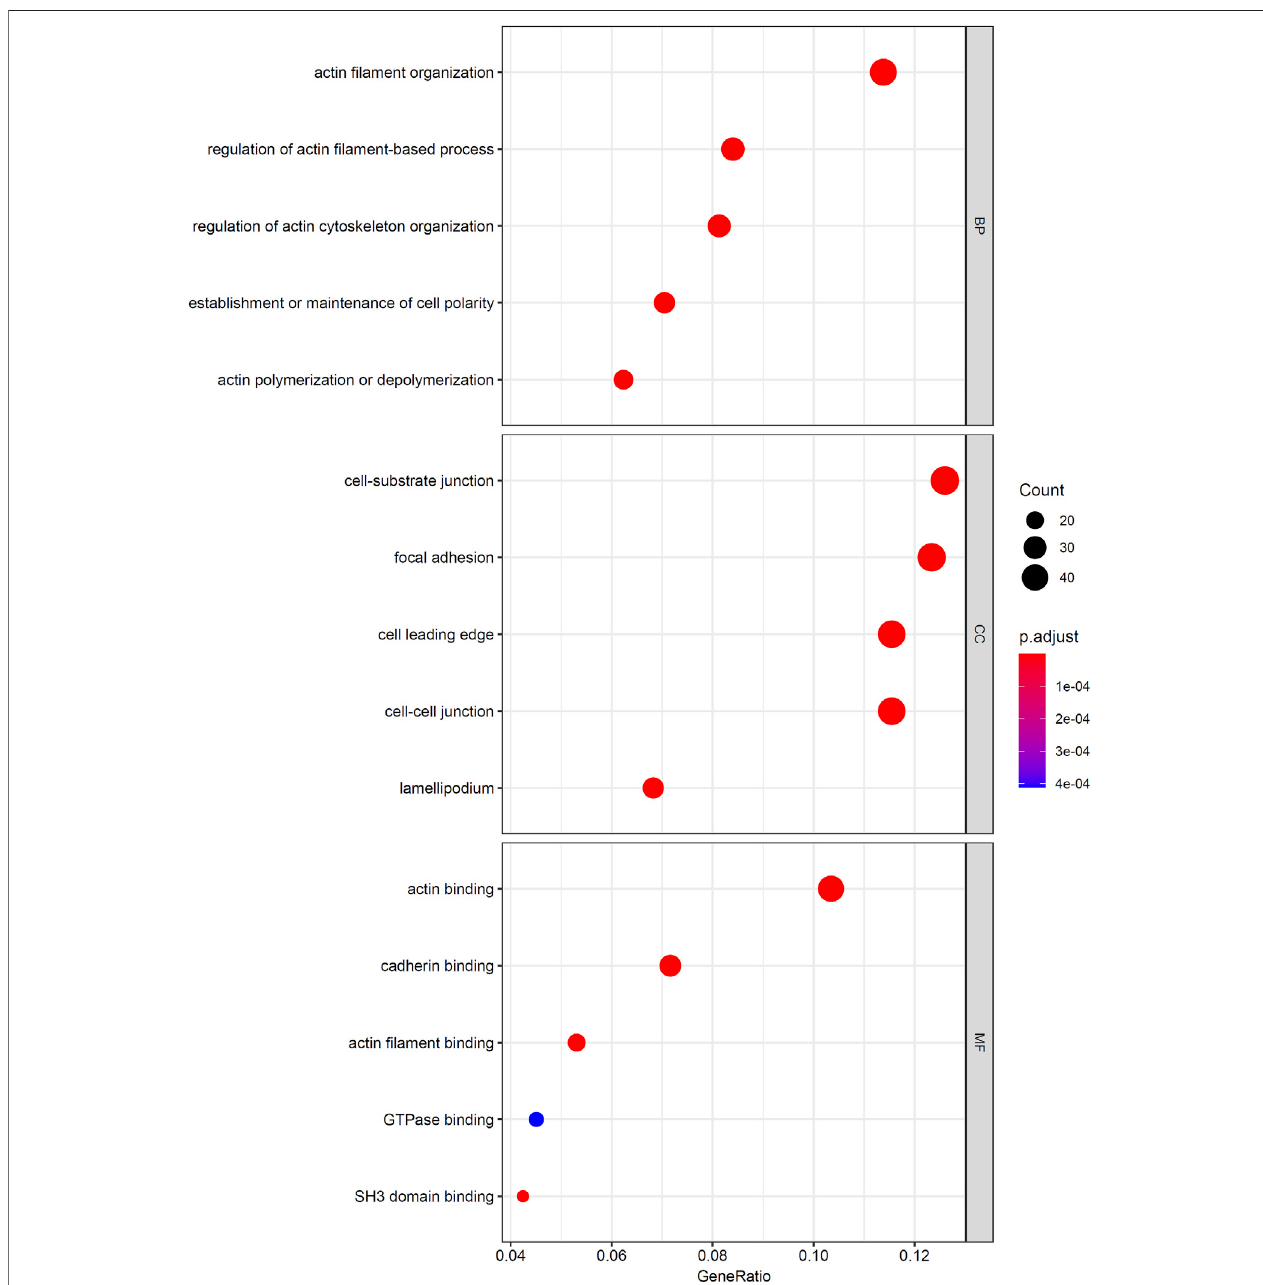
FIGURE 5 | Top enriched GO terms to the top 400 genes in the mRMR feature list.